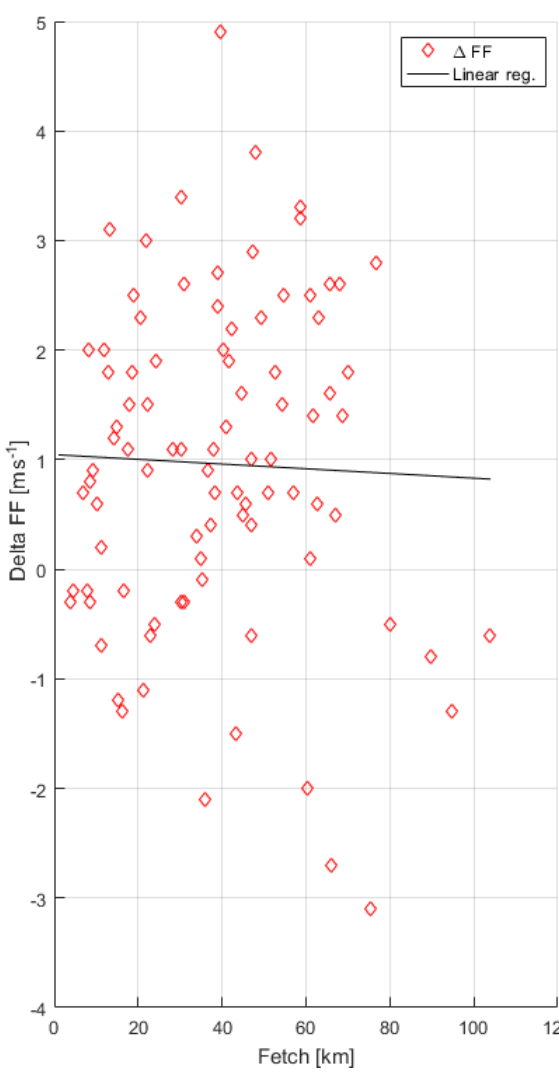
Figure 10. Changes of the wind speed at hub height (120m) from the profile closest to the coastline to the other vertical profiles de- pending on fetch length. The vertical profiles of flights 1, 3, 4, 5, 6, 7, 8, 9, 10, 13, 18, 19, 24, 30, 31, 32, 35, 36, 37, 38, 40 and 41 are included. Excluded were flights with wind direction from the north or west, where no fetch length can be